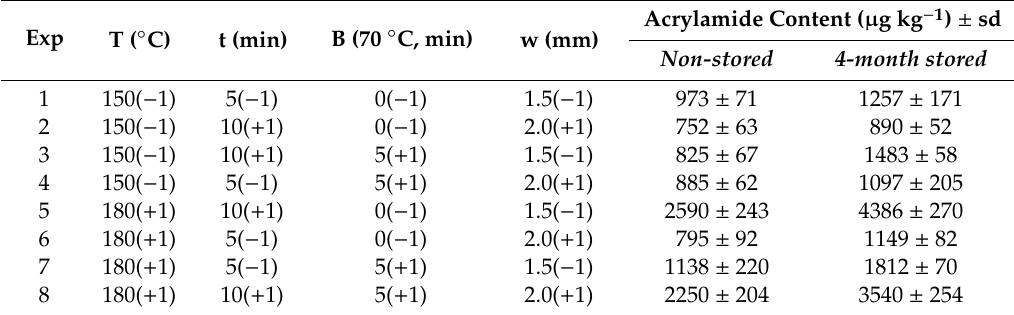
Table 1. Matrix of the experimental fractional factorial design and the average of obtained responses.